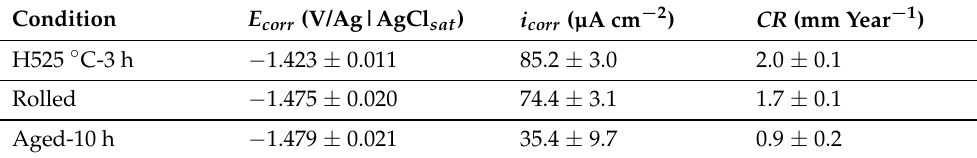
Figure 7. Potentiodynamic polarization curves of H525 ◦ C-3 h, rolled and aged − 10 h specimens in 0.9 wt.% NaCl aqueous solution at 37.0 ± 0.5 ◦ C. Table 1. Electrochemical parameters of H525 ◦ C-3 h, rolled and aged-10 h specimens: corrosion potential ( E corr ), current density ( i corr ) and corrosion rate ( CR